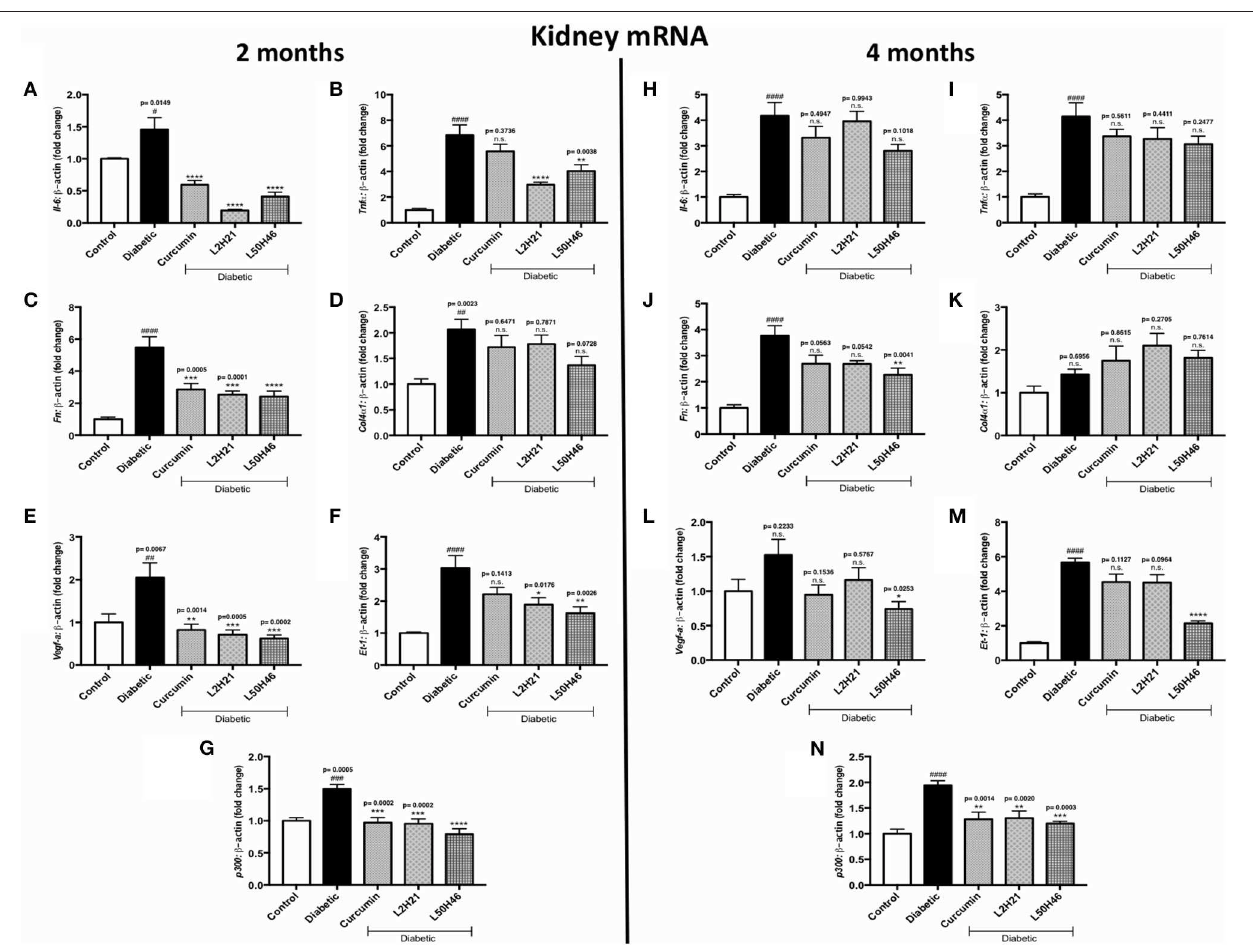
FIGURE 6 | Effects of curcumin and its analogs on renal transcripts at 2 and 4 months. Left panel: RT-qPCR analyses demonstrating significant upregulations of (A) Il-6 , (B) Tnf- α , (C) Fn , (D) Col4 α 1 , (E) Vegf-a , (F) Et-1 , and (G) p300 mRNAs in the kidney tissues of diabetic mice at 2 months. Administration of curcumin or its analogs produced differential RNA expressions. Right panel: RT-qPCR analyses exhibiting relative upregulations of (H) Il-6 , (I) Tnf- α , (J) Fn , (K) Col4 α 1 , (L) Vegf-a , (M) Et-1 , and (N) p300 transcripts in kidney tissues at 4 months. Treatment with curcumin or its derivatives also produced differential RNA expressions in the diabetic mice kidneys [data expressed as a ratio to β -actin (mean ± SEM); normalized to Control; # significance between Control vs. Diabetic; *significance between Diabetic vs. Treatment group; * , # P < 0.05, ** , ## P < 0.01, *** , ### P < 0.001, and **** , #### P < 0.0001; n = 6 animals/group; n.s., not significant; Control = non-diabetic controls; data analyzed by ANOVA followed by Tukey’s post-hoc